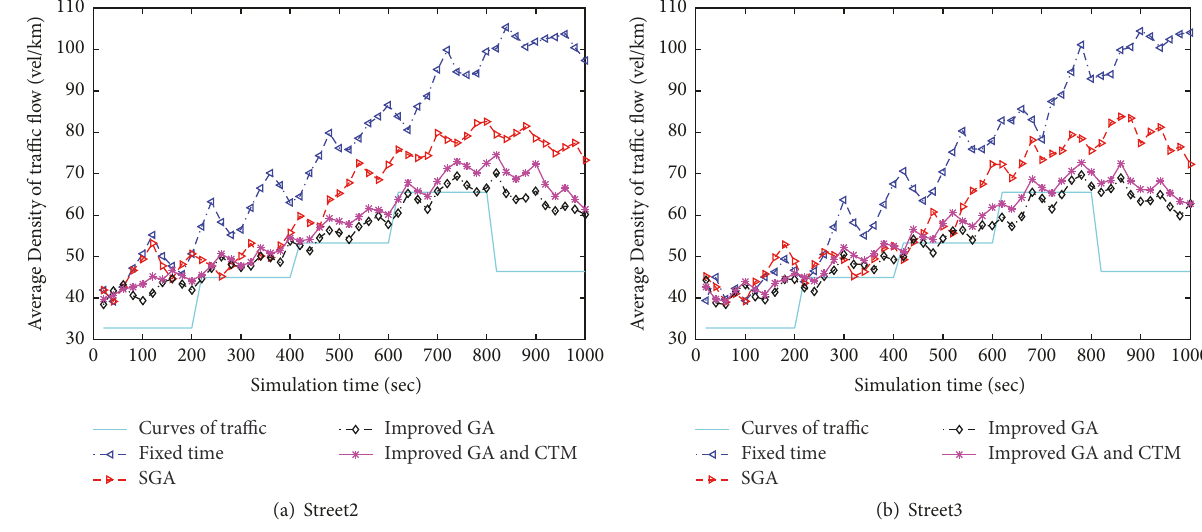
Figure 6: Curve of road traffic density and simulation